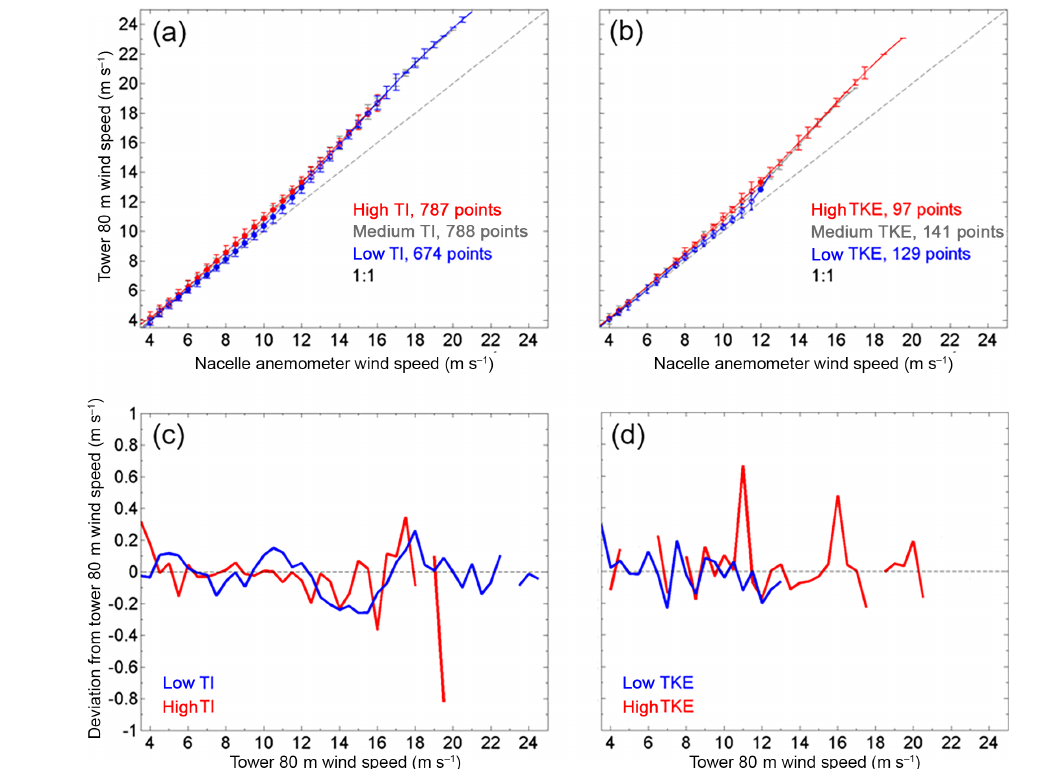
Figure 9. Tower 80m NTFs calculated using fifth-order polynomial fits with turbulence regimes based on (a) turbulence intensity (TI) and (b) turbulence kinetic energy (TKE). Error bars represent ± σ of the data within the same bins as the bins with which the NTFs are calculated. Statistically distinct differences within each wind speed bin between the stability classes are denoted by closed circles. Figures include data filtered for tower 80m wind speeds between 3.5 and 25.0ms − 1 , 87m wind directions between 235 and 315 ◦ , and for normal turbine operation. Average deviation in NTF-corrected nacelle-mounted anemometer wind speed from tower 80m wind speed is shown during stable conditions (blue) and during unstable conditions (red) versus tower 80m wind speed with turbulence regimes based on (c) TI and (d) TKE. The dashed line indicates a 0ms − 1 change. Table 6. Coefficients for fifth-order polynomial NTFs for turbulence metrics. TI TKE Regime High Med Low High Med Low a 1 − 9.0463 × 10 − 5 1.5534 × 10 −